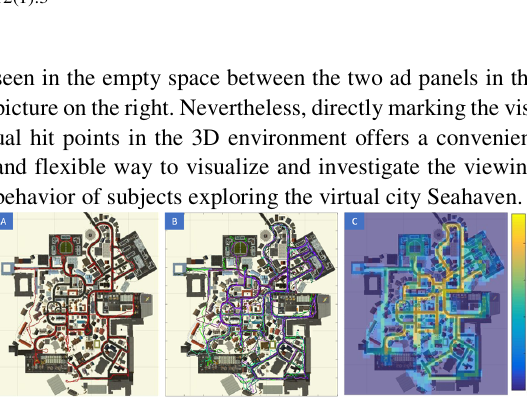
Figure 8: (A) Map of a single subject's walking path during a 30- minute session. (B) Map with walking path of 27 subjects. (C) Number of subjects that visited a certain area of the city.